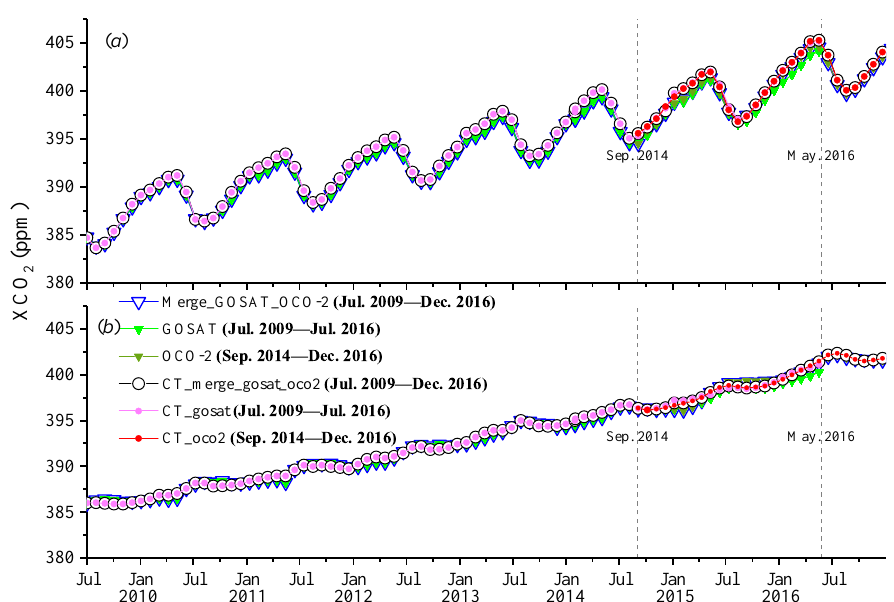
Figure 16. Monthly mean XCO 2 from satellites and CT2017 in ( a ) the Northern Hemisphere and ( b ) Southern Hemisphere. The word “Merge” in the legend indicates the combination of the GOSAT and OCO-2 scans.